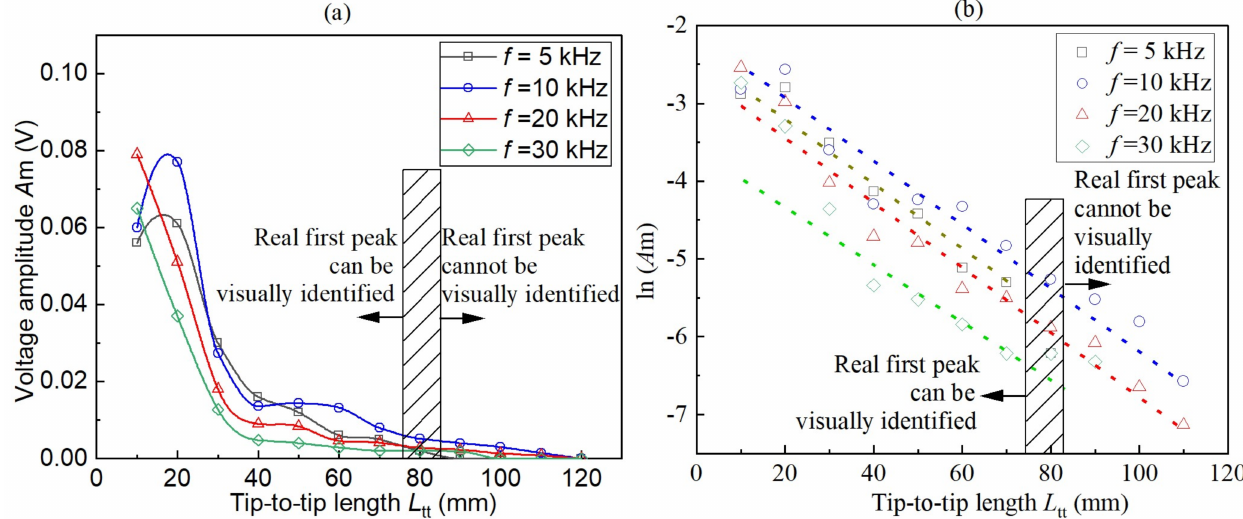
Figure 7. Attenuation curves of real first peak A in ( a ) A m - L tt scale and ( b ) ln( A m )- L tt scale.